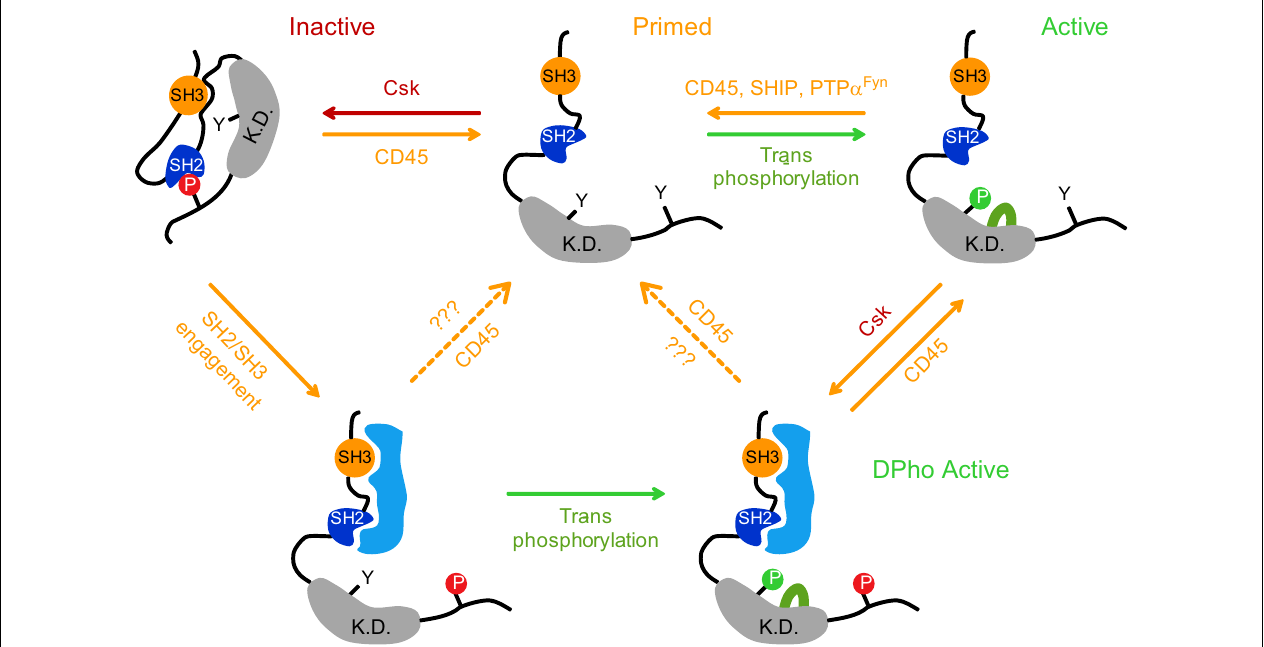
performed by CD45 or SHIP-1 or alternatively by PTP α in case of Fyn. It has been recently demonstrated that Lck can also persist in a double phosphorylated state (DPho), when both regulatory tyrosines (Y505 andY394) are phosphorylated concurrently and the kinase retains its activity (bottom structure). DPho state is likely achieved in a two-step process.The first step involves the interaction of high affinity ligand(s) with Lck SH2 and/or SH3 domain which disrupts the closed conformation and is followed by CD4-Lck aggregation-mediated trans/auto phosphorylation of pY394. Alternatively, it is generated by the action of Csk on pY394 Lck.Whether CD45 converts these isoforms to a dephosphorylated, primed conformation or to an active pY394 state in vivo , is unclear (dashed arrows). Red arrows denote negative regulation; green arrows denote positive